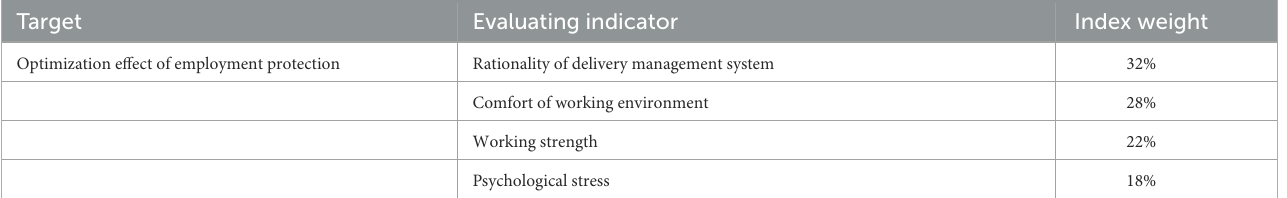
TABLE 2 Weights of employment protection optimization evaluation